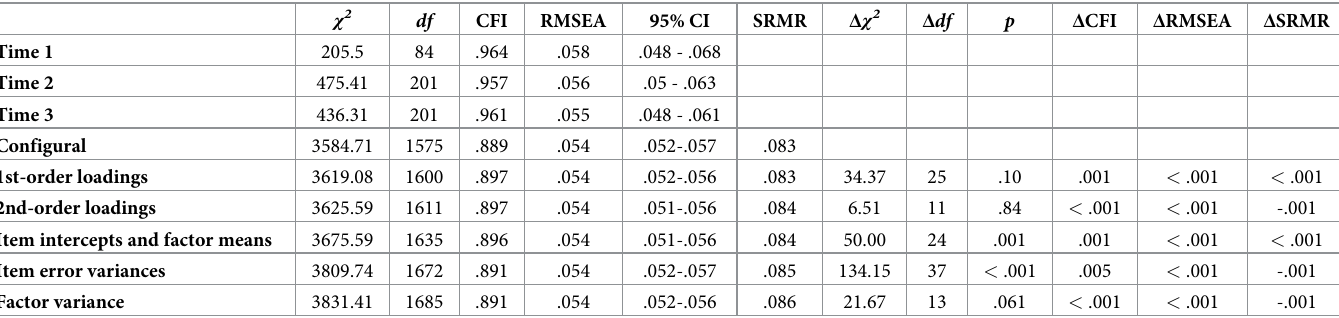
Table 3. Longitudinal measurement invariance test for Model 2.